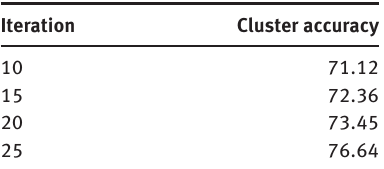
Table 1: Clustering Accuracy for Our Proposed Research.